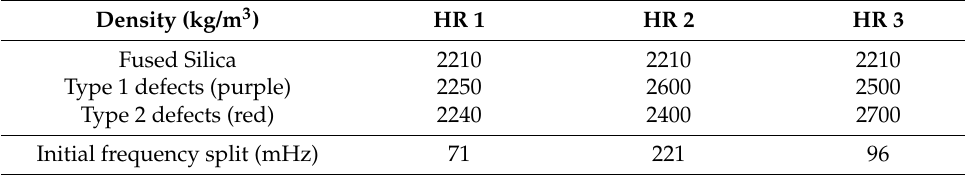
Figure 4. Finite element model of a hemispherical resonator with initial imperfect mass points. Red and purple elements are two different types of mass defects of HR 1. Table 1. Material parameters of three HRs.